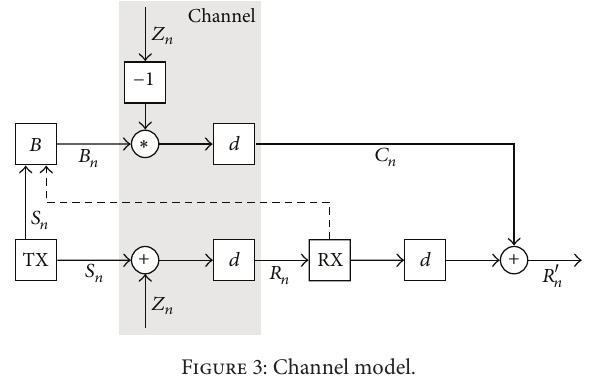
Figure 3: Channel